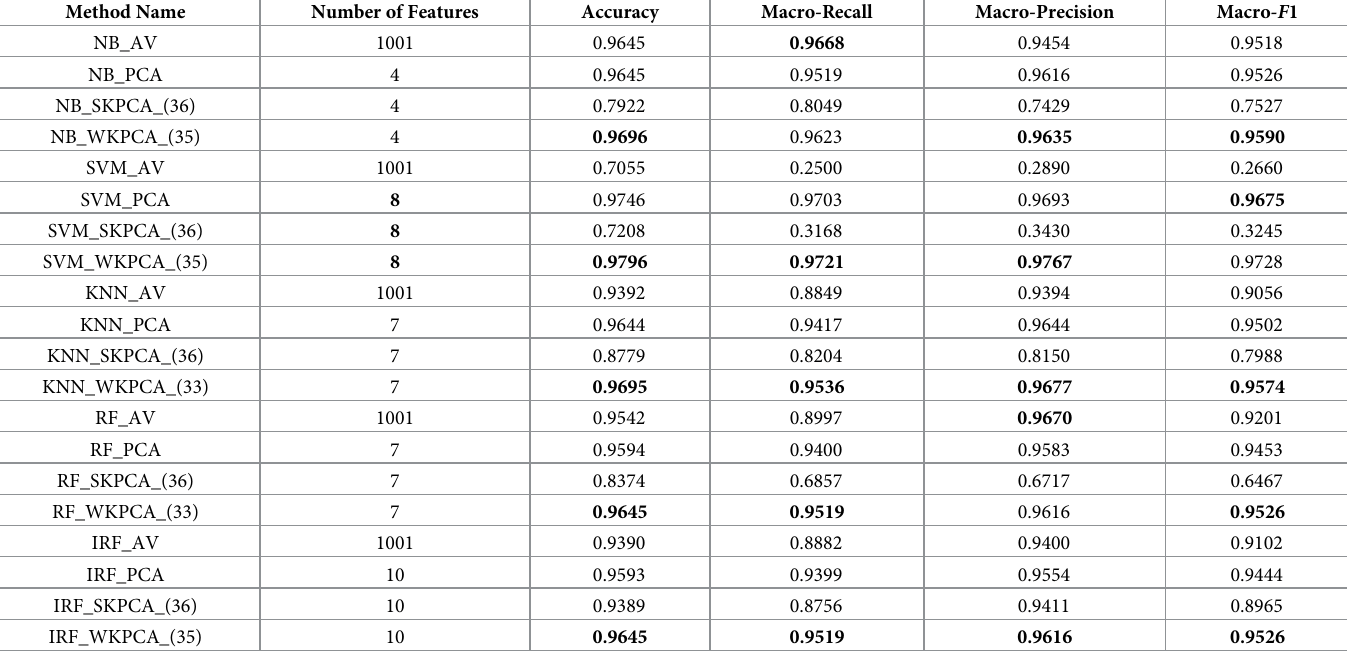
Table 8. Performance measurement comparisons of machine learning methods based on the Lung data set after WKPCA dimension